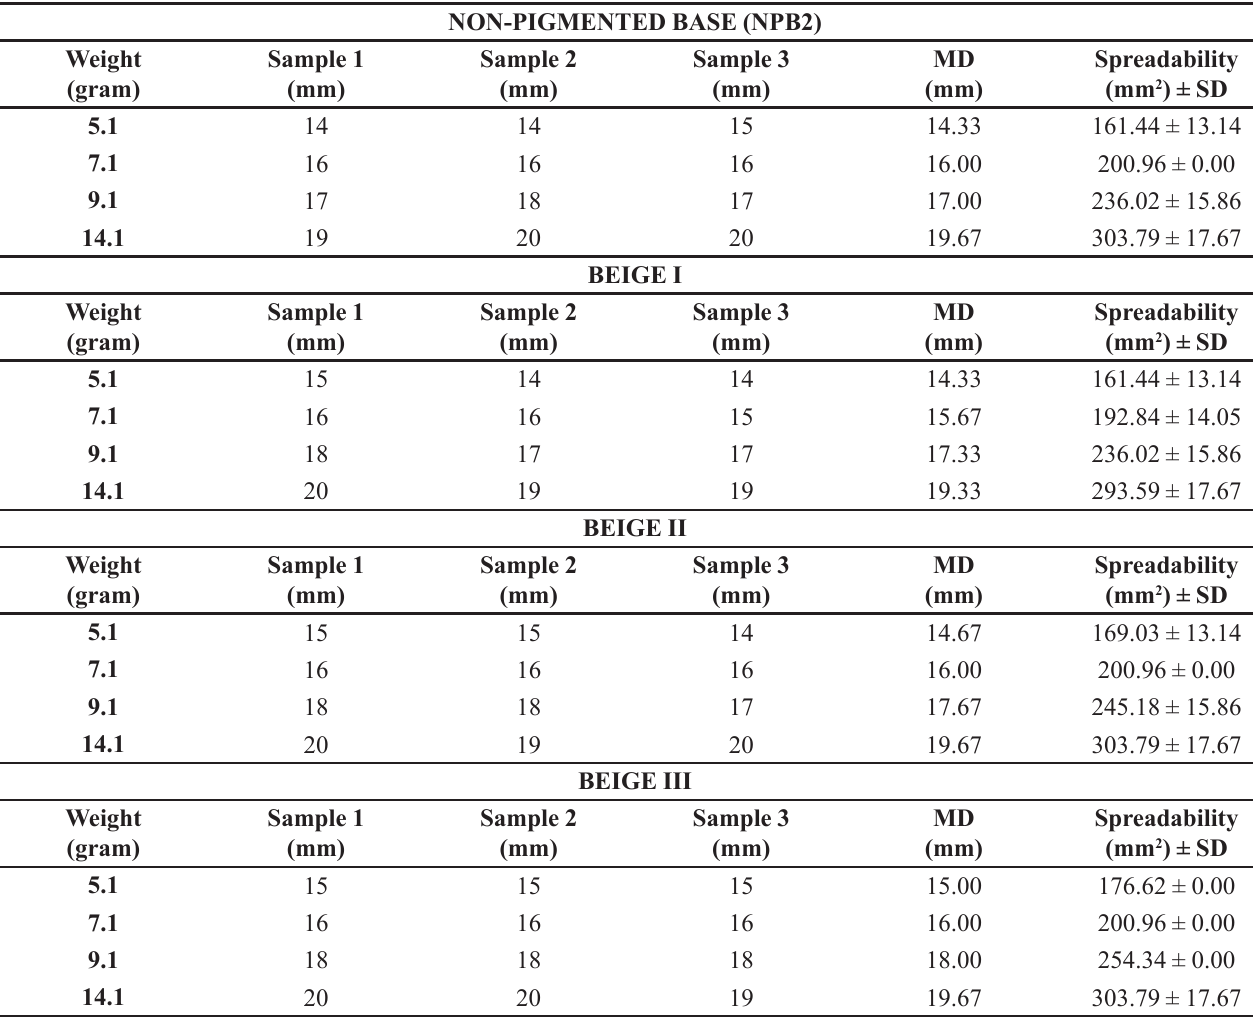
TABLE XVI - Results obtained from the spreadability test with the emulsive base NPB2 and corrective